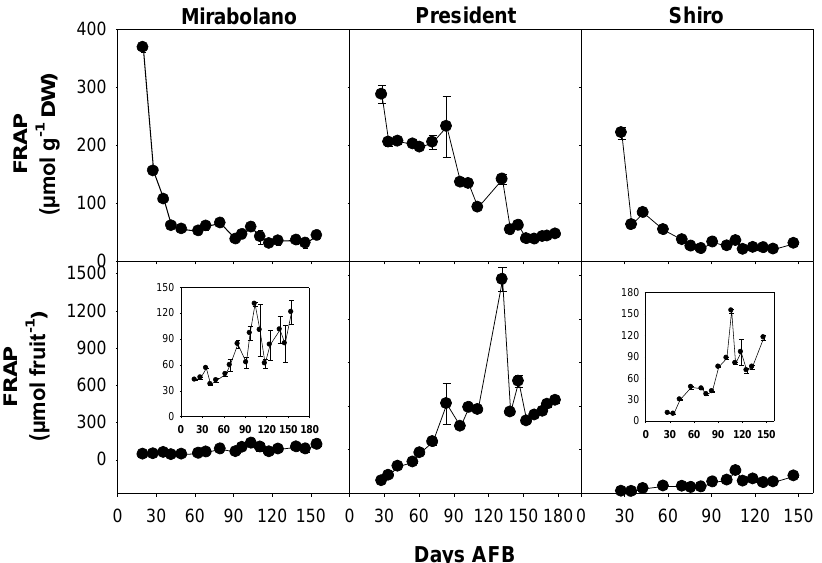
Figure 6. Antioxidant activities of the flesh (mesocarp + epicarp), expressed as ferric reducing antioxidant power (FRAP), of fruits of Prunus cerasifera —Mirabolano, Prunus domestica —cultivar President, and Prunus salicina —cultivar Shiro at different stages of development. Each point on the graph shows the mean and standard error, n = 3. AFB = after full bloom. Table 2. Antiradical activities (mean value ± standard error, n = 3) of the fruit flesh of the three plum species at di ff erent development stages.